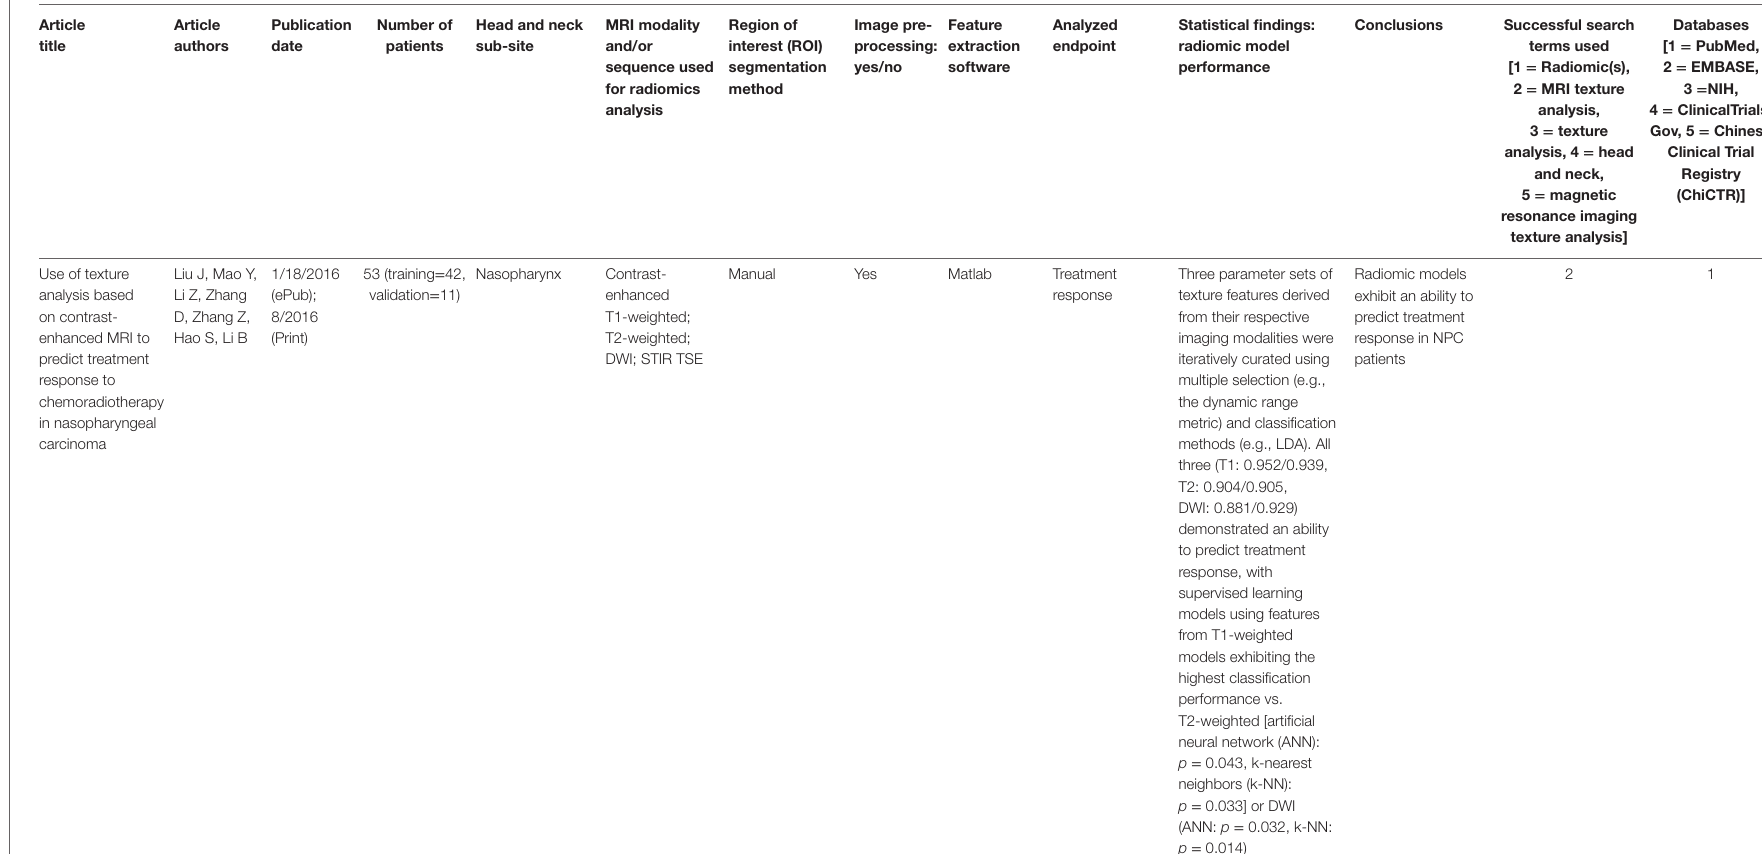
Treatment response